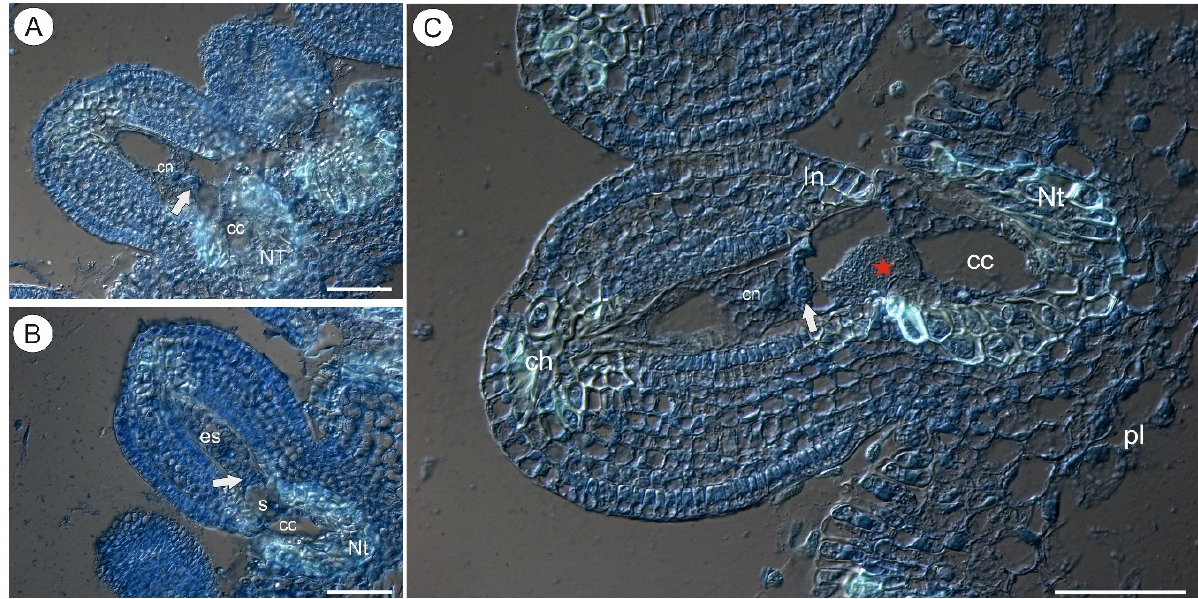
Figure 1. Histology of an ovule of Utricularia nelumbifolia ; differential interference contrast (DIC) optics. Sections stained with DAPI (blue fluorescence) and DAB (decolorized aniline blue, white fluorescence). ( A , B ) Ovules before penetration by the pollen tubes. ( C ) Ovule after penetration by the pollen tube (red star). Note the egg cell (arrow), embryo sac (es), synergid (s), nucleus of the central cell (cn), hypertrophied part of the central cell (cc), placental nutritive tissue (Nt), integument (In), chalaza (ch), placenta (pl). Note callose occurrence (white fluorescence) in the cell walls of the placental nutritive tissue cells and chalaza cells. All bars 50 µm.